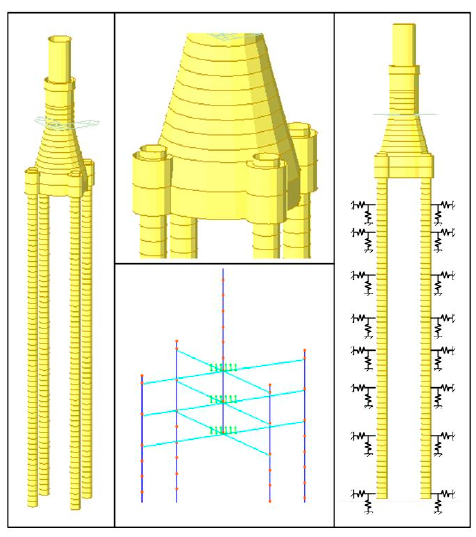
Figure 5. Modeling of PCF.